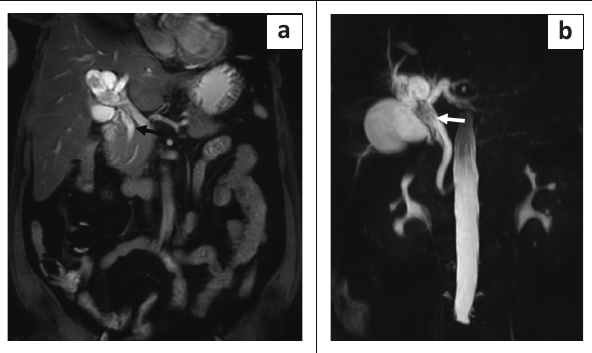
FIGURE 4: (a) Balanced Turbo Field Echo (BTFE) coronal section showing the dilated downstream common hepatic duct and CBD (black arrow), separate from the lesion at the primary confluence. The site and extent of the intraductal tumour is best seen on the volumetric MIP of the magnetic resonance pancreatico- cholangiography (b), indicating extension of the tumour into the common hepatic duct (white arrow) with upstream and downstream ductal